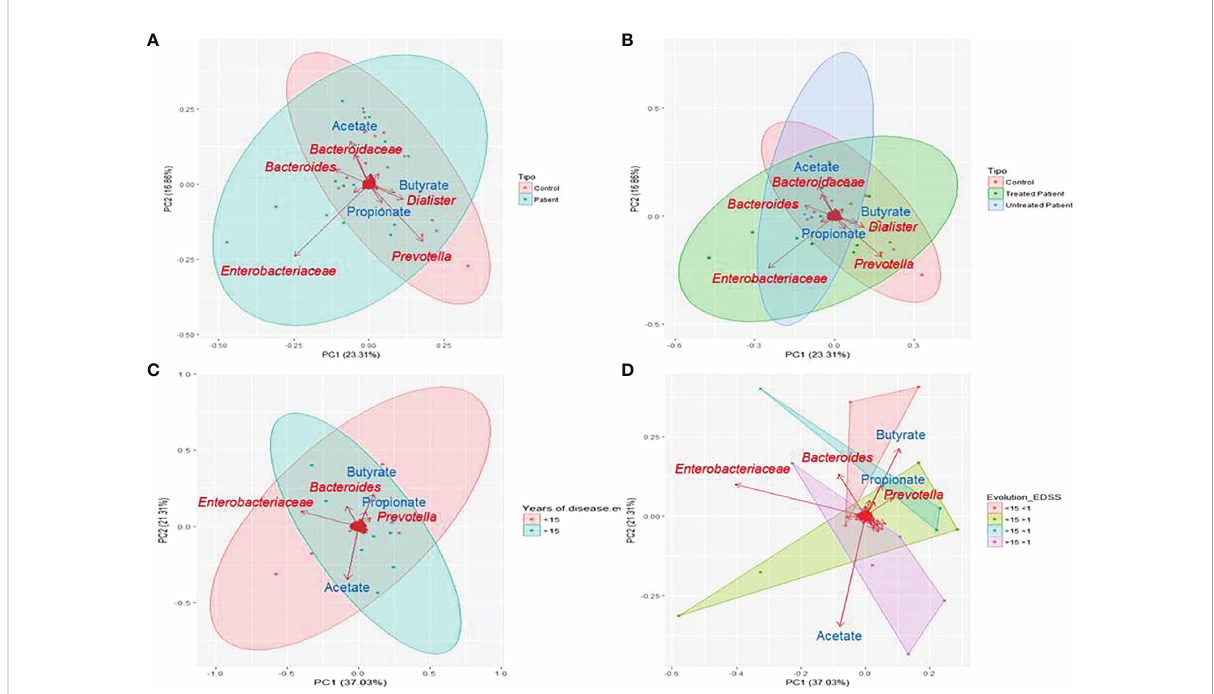
FIGURE 4 Principal component analysis (PCA) of microbiome results. PCA was performed based on the reads detected at each sample. Clustered samples were represented in different colours and the bacterial groups and produced SCFAs that had a higher in fl uence placing the samples were represented with arrows. The bidimensional PCA plot (A, B) explains 40% of the sample ’ s variability. In (A) samples were clustered in patients (blue) and controls (red) (PERMANOVA P=0.218), while in (B) patients were divided on treated (green) and untreated (blue) (PERMANOVA P=0.199). PCA plot (C, D) explains 53.3% of the variability in the samples, that were clustered according to the years of disease evolution (C) in more or less than 15 years (blue and red respectively) and according to disease evolution (PERMANOVA P=0.675) (D) in less than 15 years of evolution and EDSS score more or less than 1 (green and red respectively) or more than 15 years of evolution and EDSS score more or less than 1(violet and blue respectively) (PERMANOVA